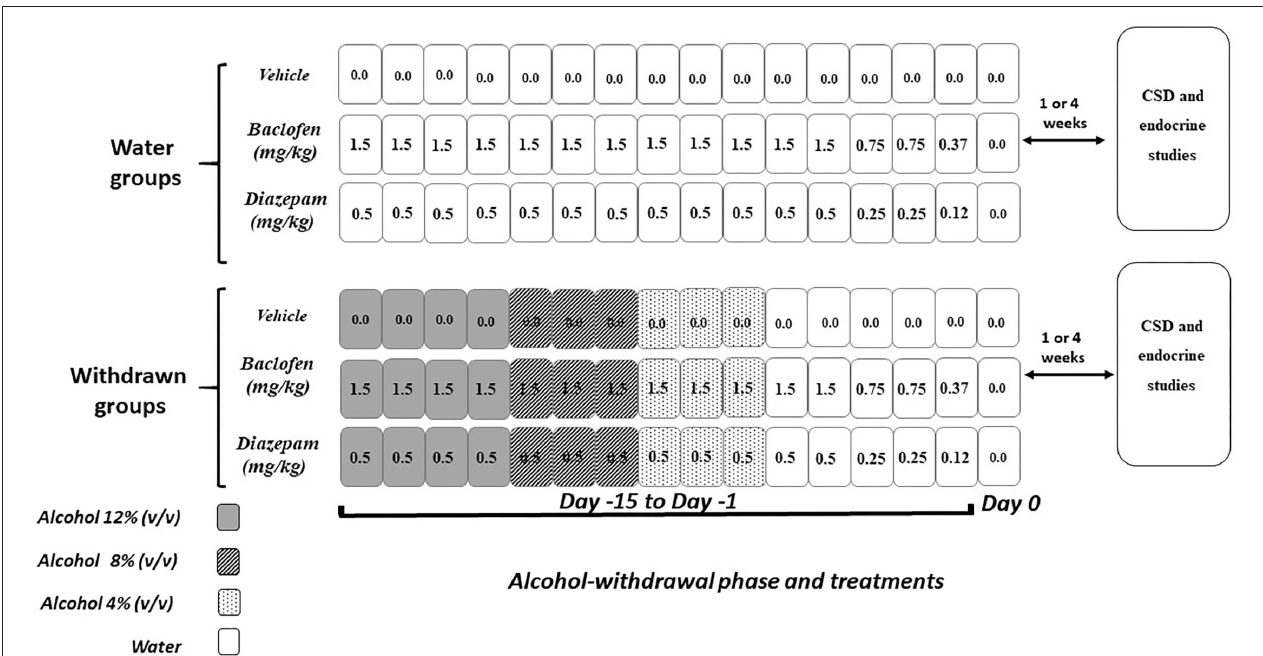
FIGURE 3 | Pharmacological procedure. Diazepam and baclofen were administered by intraperitoneal injection (1/day) both in control (Water groups, upper part) and in withdrawn mice (withdrawn groups, lower part) during 15 consecutive days (Day − 15 to Day − 1). The pharmacological treatments started when withdrawn mice were still under the alcohol regimen (12% v/v, 4 consecutive days, dark rectangles), then 8% v/v (next 3 consecutive days gray rectangles), and finally 4% v/v (3 remaining consecutive days, light gray rectangles) followed by water (white rectangles). All mice received on the first 12 days of treatment either vehicles or diazepam at 0.5 mg/kg or baclofen at 1.5 mg/kg, followed at Days 3 and 2 by doses being half of the starting dose- − 0.25 and 0.75 mg/kg, respectively, for diazepam and baclofen—and finally (Day − 1) by 0.12 or 0.37 mg/kg diazepam and baclofen doses, respectively. Control groups receiving water were submitted to the same pharmacological procedures as those used in withdrawn groups. Behavioral testing and endocrinological studies occurred either 1- or 4-weeks after the last